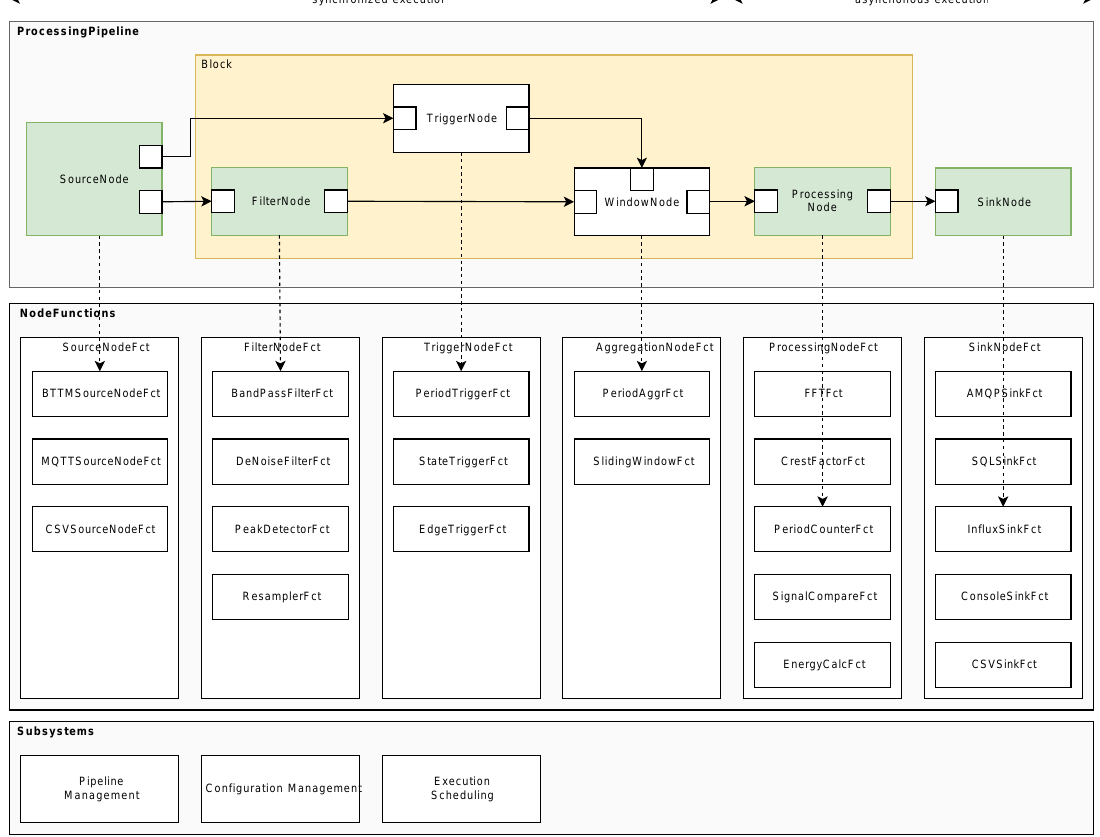
Figure 14. Overview of the sensor processing